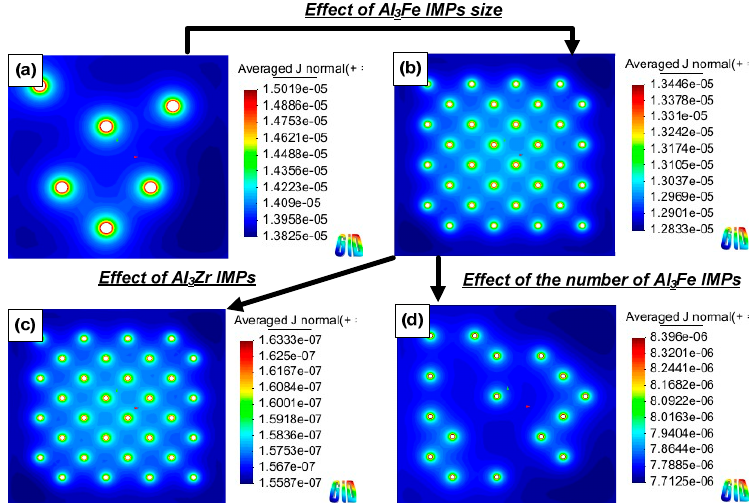
Figure 11. Current distribution of each simulation case; ( a ) large size of IMPs (large IMPs area)–Al 3 Fe; ( b ) small size of IMPs (large IMPs area)–Al 3 Fe; ( c ) small size of IMPs (large IMPs area)–Al 3 Zr; and ( d ) small size of IMPs (small IMPs area)–Al 3 Fe.